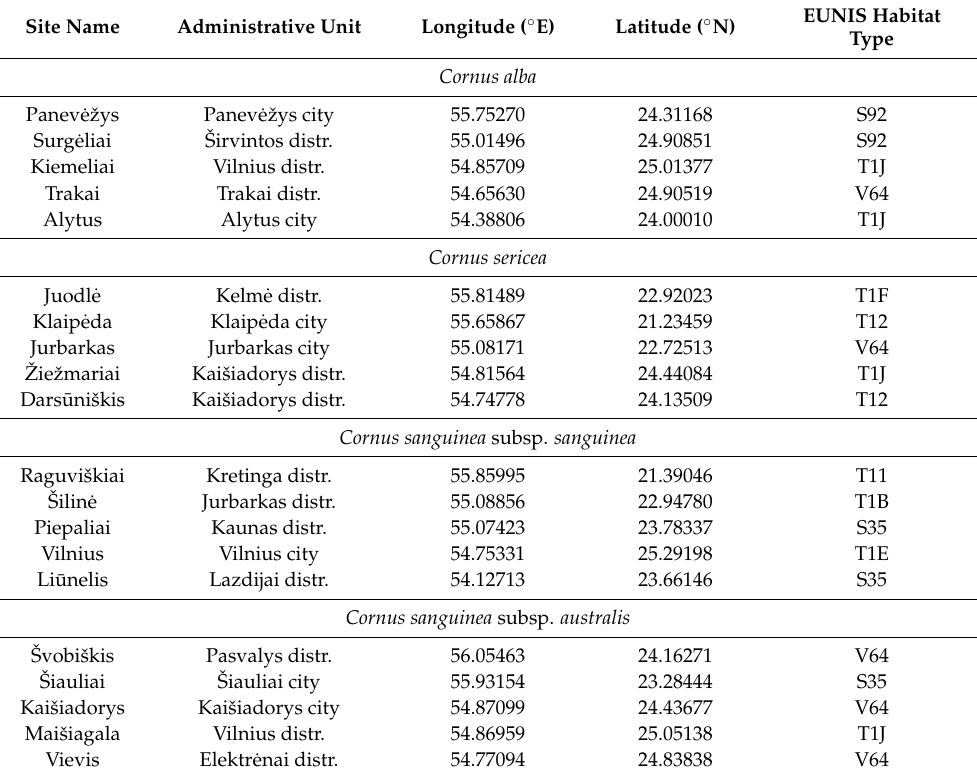
Table 1. List of the study sites of the Cornus soil seed bank in Lithuania, with their administrative position, geographical coordinates and EUNIS habitat types.